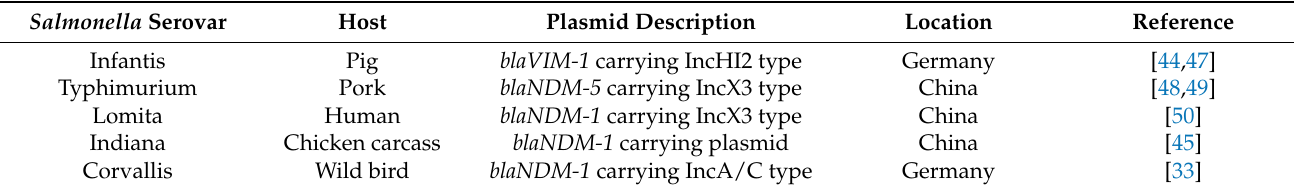
Table 1. Salmonella serovars carrying carbapenem resistance genes in food animals and humans. Salmonella